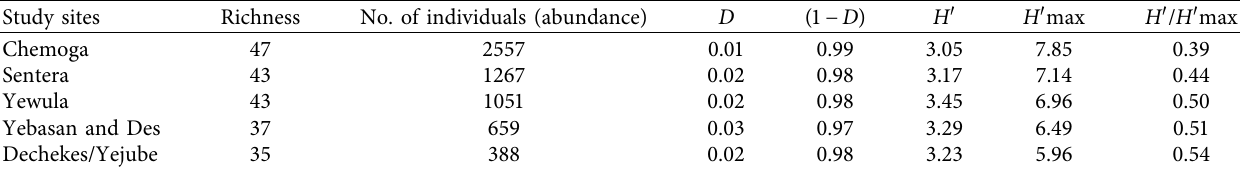
Table 1: Avian species diversity, evenness, and dominance during the study period.